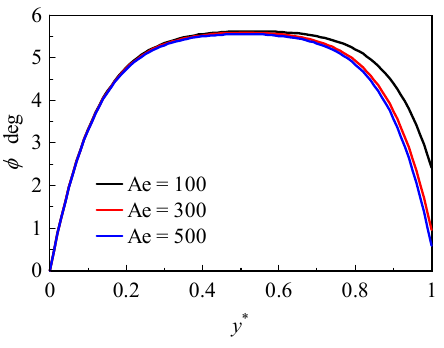
Fig.6 Director angle profiles at steady state